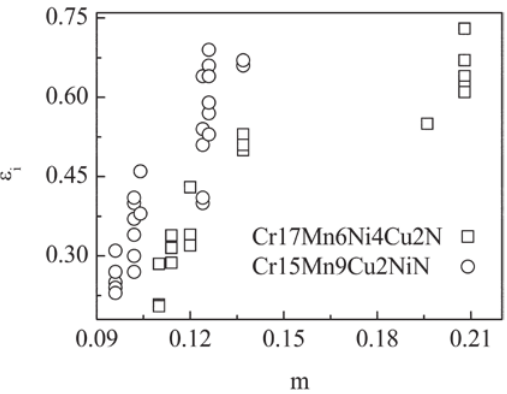
Fig. 7: Effect of temperature on m and n value